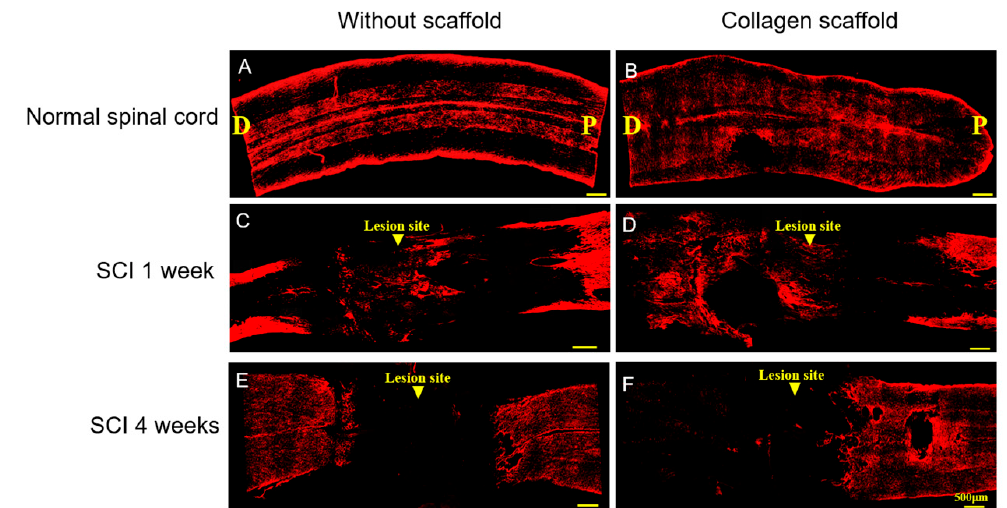
Figure 6. Immunofluorescence staining of glial fibrillary acidic protein (GFAP) in the injured site of the spinal cord 1 week and 4 weeks post-implantation. ( A , B ) Rat normal spinal cord without and with collagen scaffold, respectively; ( C , D ) rat SCI model without and with collagen scaffold after 1 week post-implantation, respectively; ( E , F ) rat SCI model without and with collagen scaffold after 4 weeks post-implantation, respectively. (D = dorsal; P = posterior)